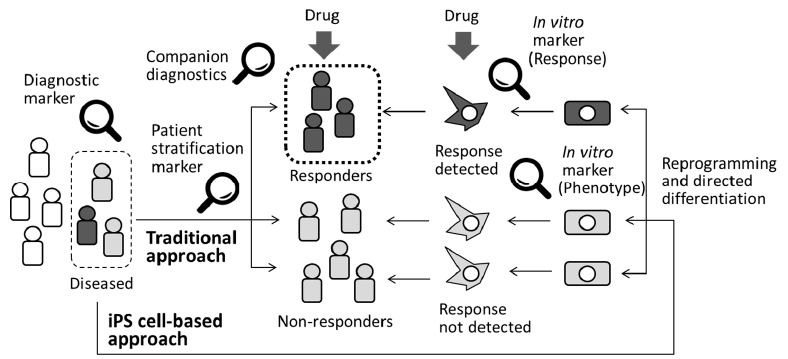
Figure 2. Diagnosis and patient stratification by using biomarkers. Application of iPS cell-based approach would be alternate way to identify drug responders and non-responders.